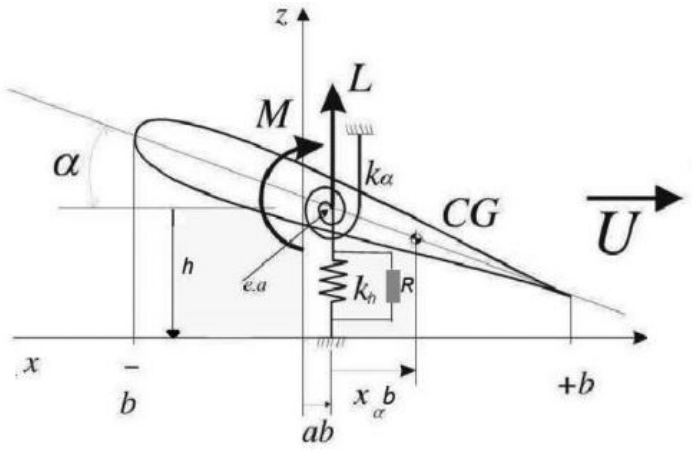
Figure 9. Piezoaeroelastic system schematic [148]. A three-degrees of freedom (DOF) airfoil supported elastically by linear plunge and linear torsional